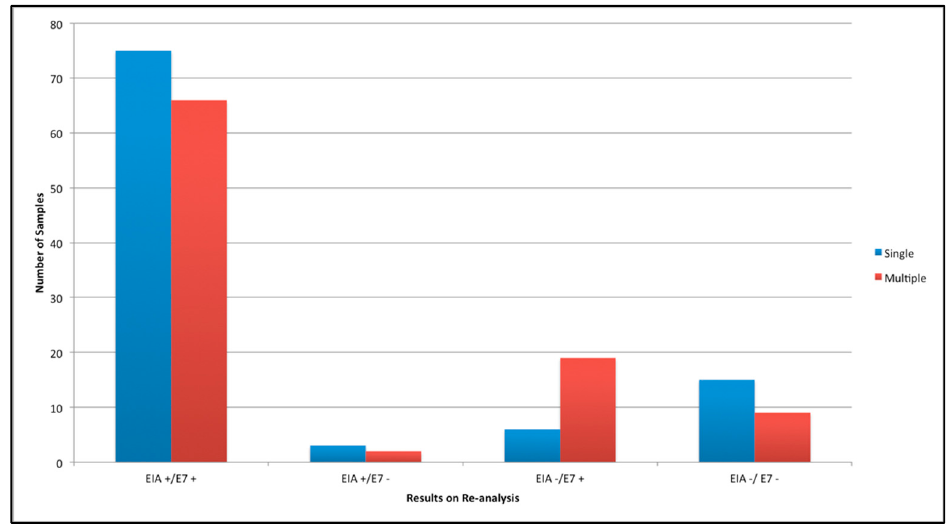
Figure 3. HPV 51 results from re-analysis with GP5+/6+ PCR EIA and E7 PCR (E7): singles and multiples.